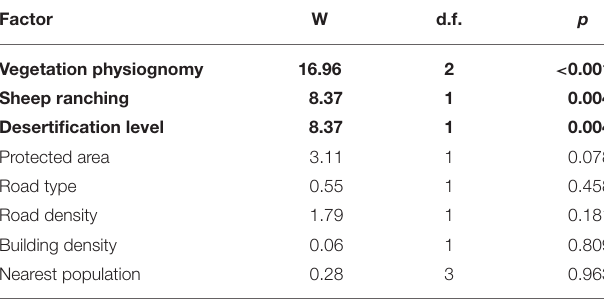
TABLE 5 | Effect of predictive factors on the group encounter rate